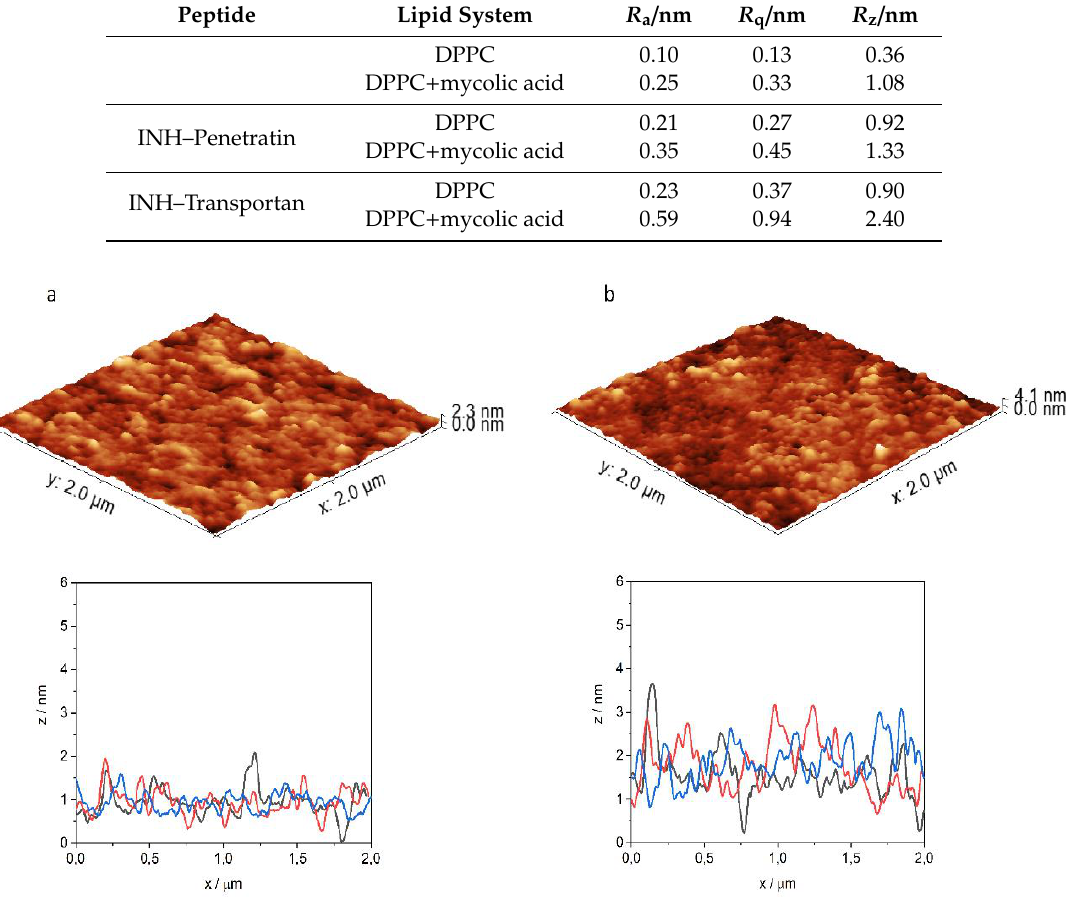
Figure 5. Three-dimensional atomic-force microscopy image of DPPC ( a ) and DPPC + mycolic acid ( b ) lipid layer after 1 h interaction with INH–Penetratin, and characteristic cross-section profiles of the penetrated films.